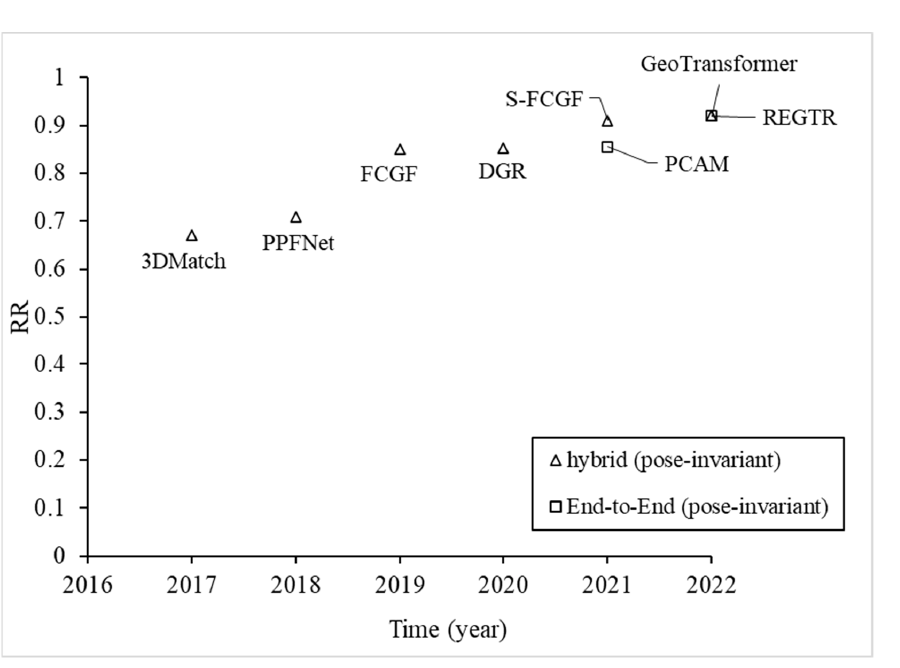
Figure 6. RR for ‘hybrid’ and ‘end ‐ to ‐ end’ registration methods of the best performance(s) in each of recent years, based on the 3DMatch dataset. The Presented methods are 3DMatch [32] , PPFNet [33] , FCGF [35] , DGR [68] , S ‐ FCGF [69] , PCAM [59] , REGTR [60] , and GeoTransformer [70]